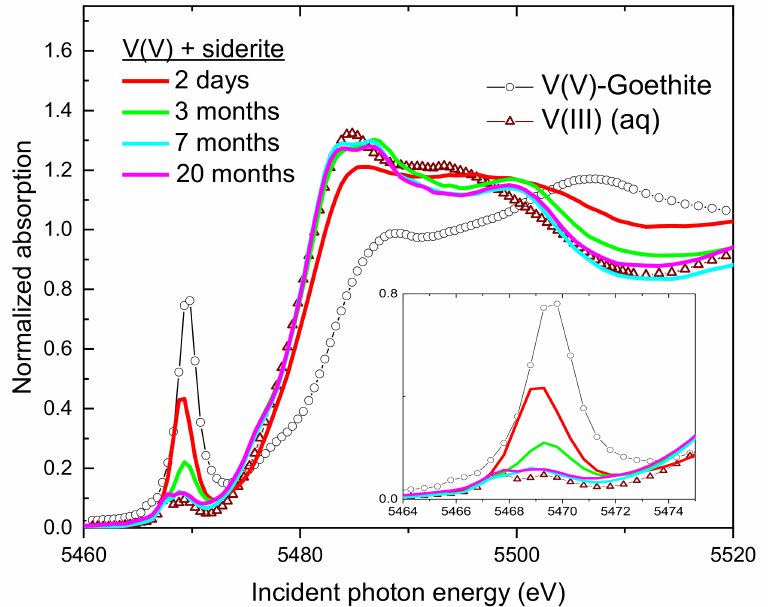
Figure 4. The V K-edge XANES spectra of the solids in the siderite system over time compared to representative standards V(V) sorbed to goethite and aqueous V(III). Inset shows details in the pre-edge region.